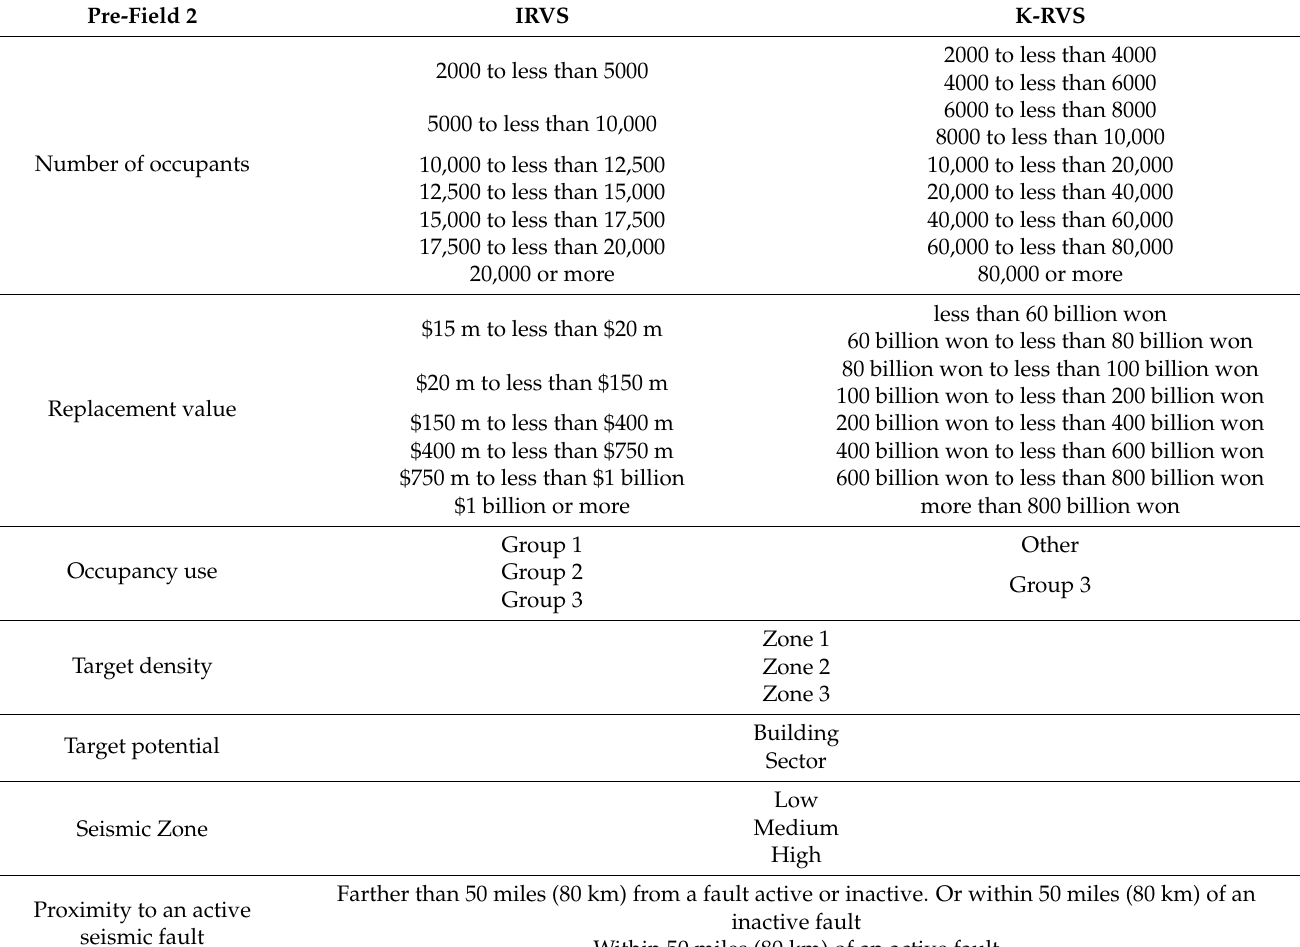
Table 3. Comparison table for pre-field 2 between IRVS and